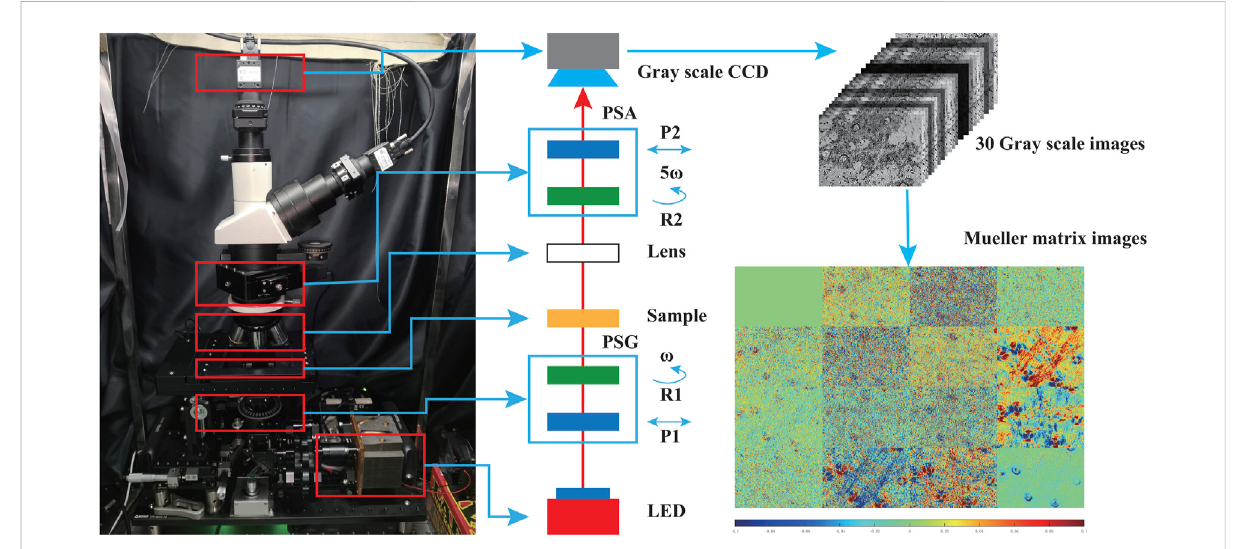
FIGURE 1 Photo and schematic of the Mueller matrix microscope; lens: objective lens; P1 and P2: polarizers; R1 and R2: quarter-wave plates; PSA: polarizationstateanalyzer;PSG:polarizationstategenerator.Duringthemeasurement,thetwoquarter-waveplatesrotatewithconstantrates( ω for R1 and 5 ω for